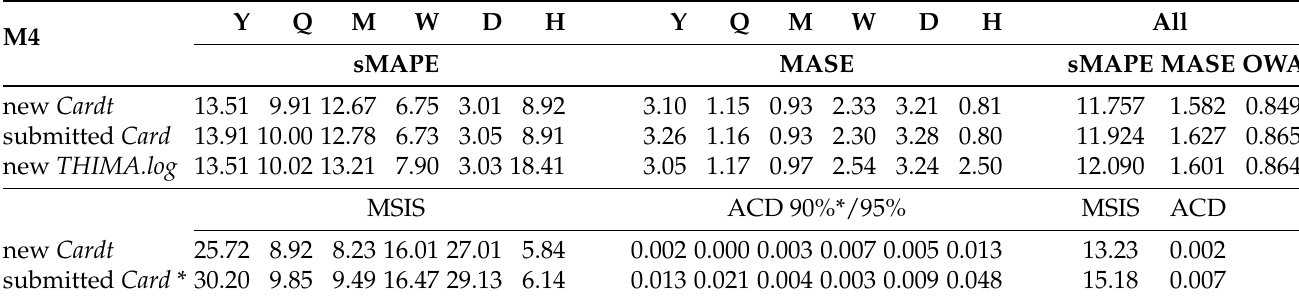
Table 7. Summary performance in M4 competition. Absolute coverage difference (ACD) is for a 95% forecast interval except for submitted Card which used 90%. OWA is the overall weighted average of sMAPE and MASE, with weights determined by the relative number of series for each frequency. * denotes used ACD at